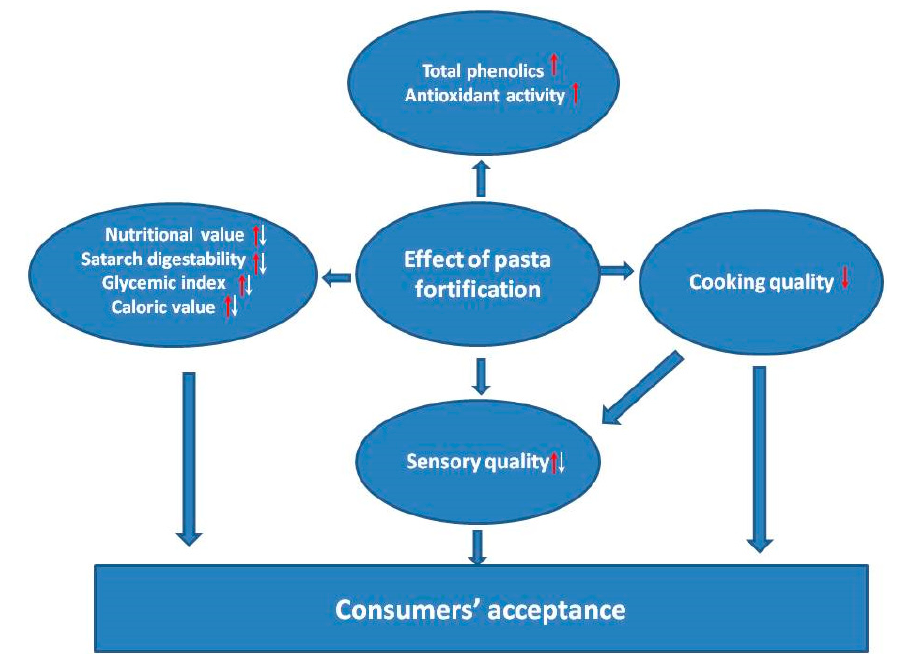
Figure 2. Effect of pasta fortification and factors influencing consumers’ acceptance of pasta. In particular, such additives as dried blackberry, raspberry, black and red currant powder, grape pomace, powdered whey, and beef emulsion increased both the nutritional value and antioxidant activity of pasta without a negative influence on consumer acceptance.